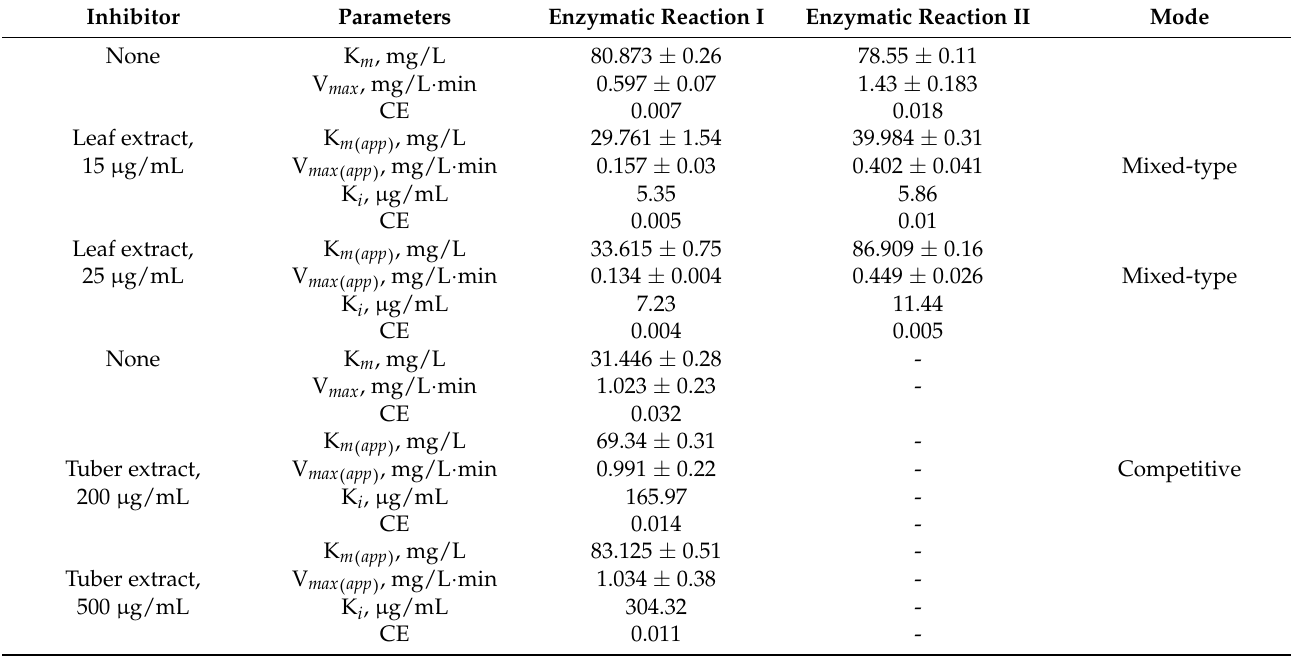
Table 3. Parameters of α -glucosidase inhibition